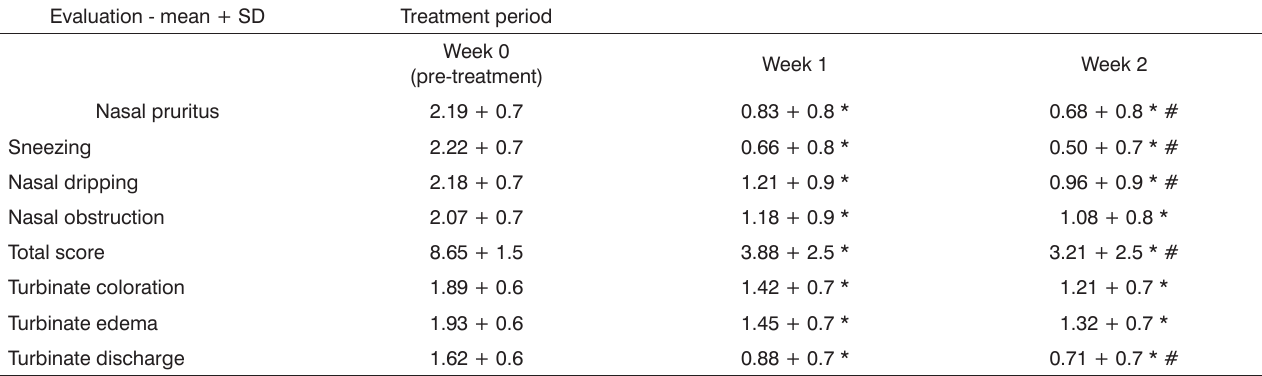
Table 2. Two-week evolution of signs and